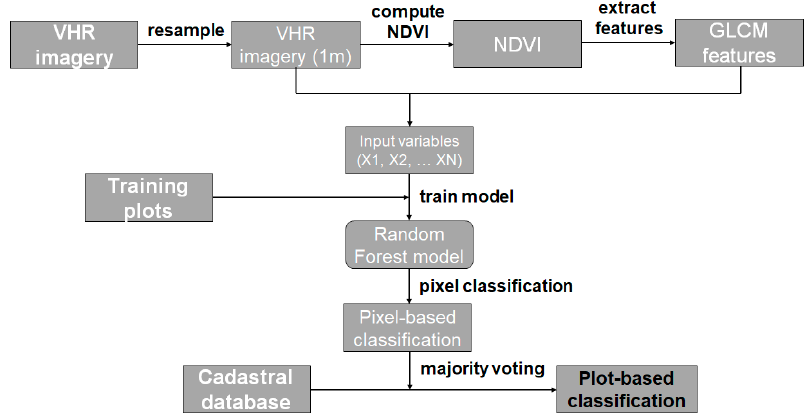
Figure 3. Workflow describing the image processing and classification. The NDVI band was discretized in 32 gray levels to compute the GLCM